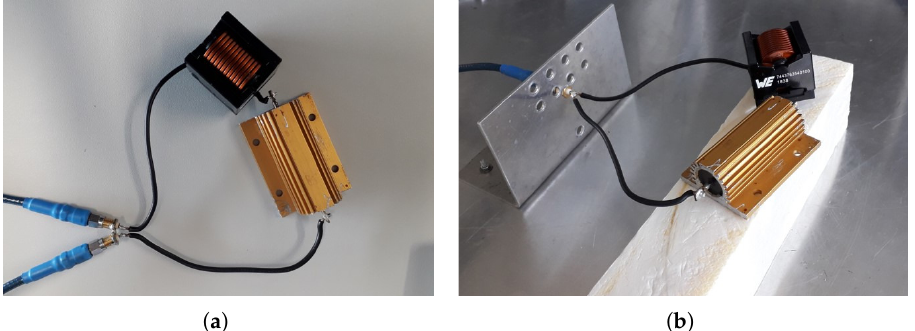
Figure 6. ( a ) Measurement of the load’s series impedance with a 2-port VNA. ( b ) Measurement of the coupling capacitance between load and GND plane to obtain the value of C CM,load . Here, only one port of the VNA is used, with both wires soldered to the inner conductor of the SMA connector. Reference is the metal fixture connected to the GND